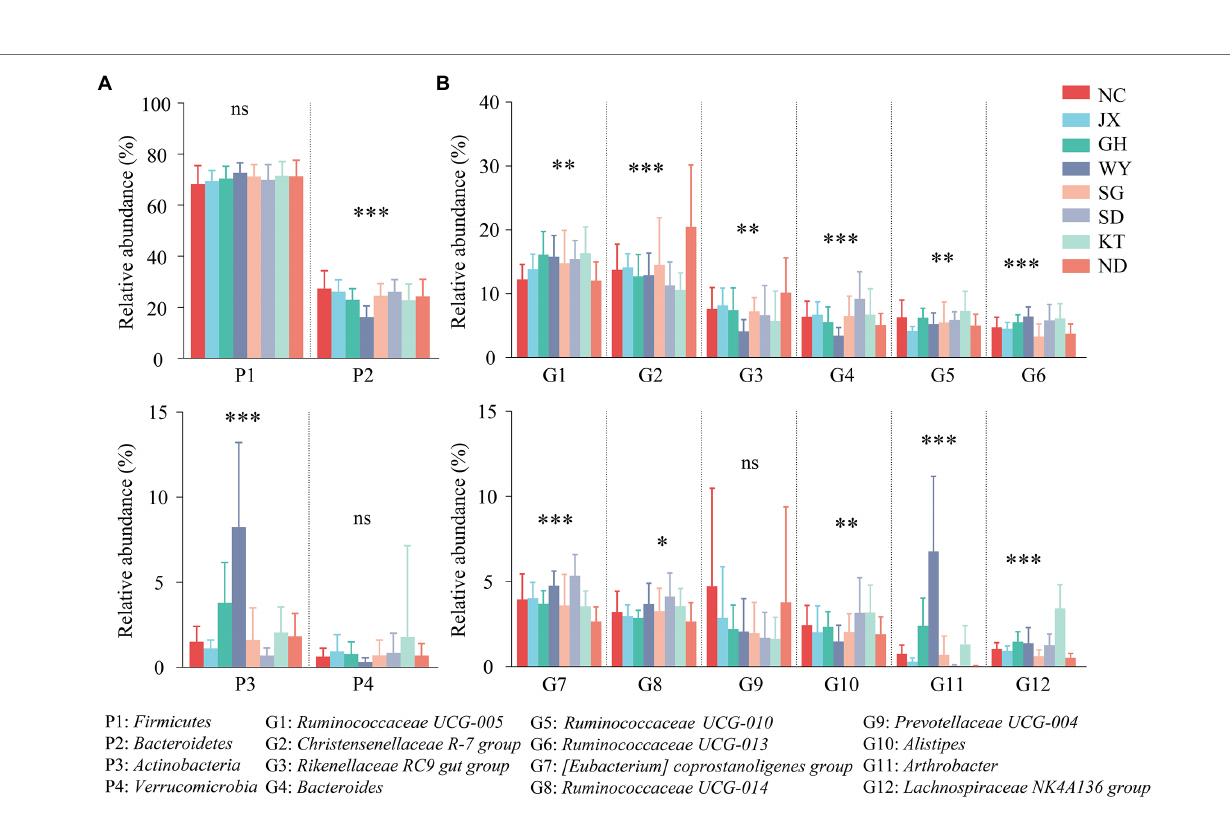
FIGURE 5 | Analysis of the differences between the dominant bacteria in Przewalski’s gazelle at the phylum (A) and the genus (B) levels. * p < 0.05; ** p < 0.01; and *** p < 0.001. ns, no